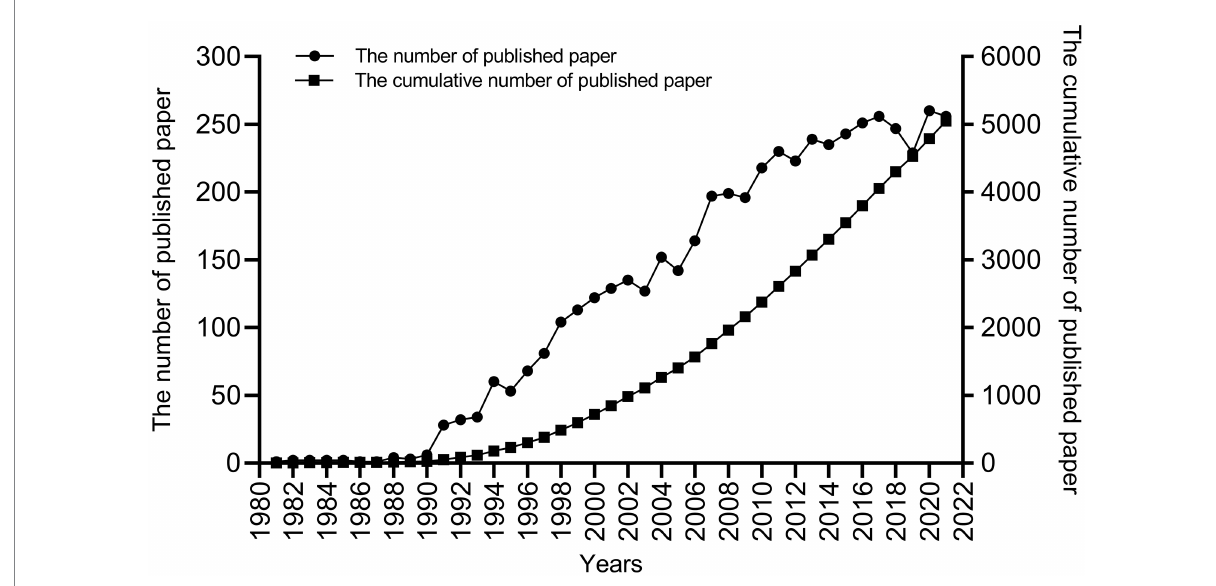
FIGURE 2 The number and cumulative number of publications in the period from 1981 to 2021.